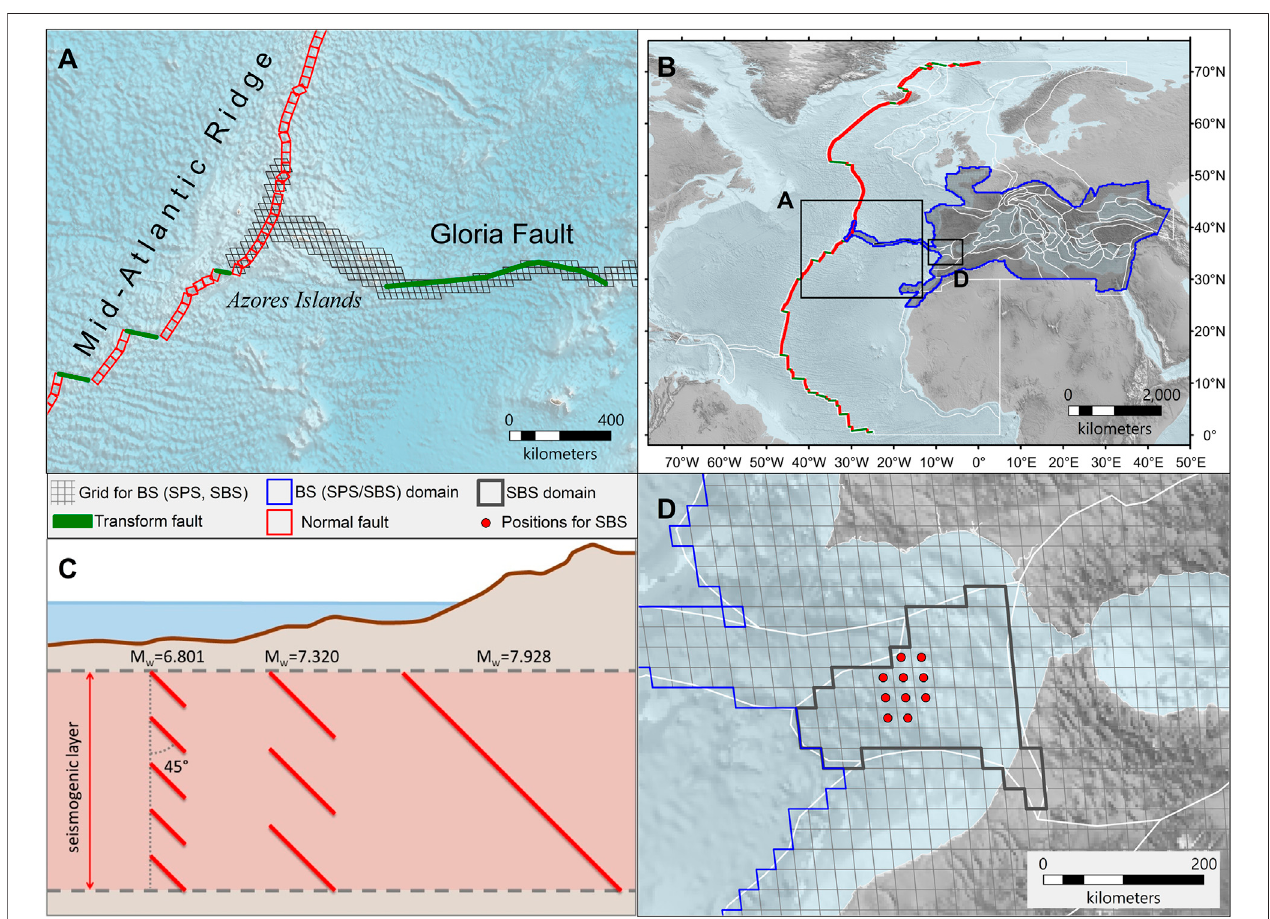
FIGURE 6 | (A) Close-up view of the Predominant Seismicity modeling type (PS) discretization in subfaults of the Mid-Atlantic Ridge and the Gloria Fault near the Azores Islands. Location of this map in panel (A) . There are in total 270 rectangular subfaults; 214 normal faults with a constant dip angle of 45 ° and size of 40 × 45 km; 57strike-slip(transform)faultswithaconstantdipangleof90 ° andsizeof55 × 20 km.See SupplementaryTableS6 forthecombinationsofsubfaultstomakeuplarge ruptures. The grid for the BS and SPS in this zone is also shown. (B) Regular grid (grey quadrangles, see the zoomed-in inset) composed of non-conformal equal- area cells of 25 × 25 km with the origin at 24 ° N – 3 ° E for the discretization of the background seismicity modeling type (BS). Note that cell sides depart from right angles withincreasingdistancefromtheorigininthisprojection.Theredoutlinemarksthecalculationdomain,outsidewhichonlythepredominantseismicitymodelingtype(PS) is modeled. The white outline of the tectonic regionalization ( Figure 4A ) is shown for reference. (C) Schematic of depth discretization for BS and SPS types due to the magnitude ofearthquakerupturesapplied to thecenter ofeach cell ofthegrid. Forthe SBStype, the magnitude range isextended toMw (cid:3) 9.026, and the depthlimit of thecrustalmodelisignored.Allmagnitudesarealwaysmodeledfortheshallowestdepthposition,irrespectiveofthecrustalthicknessbeingexceededornot.Wherethe crust isverythin, someofthedeeperpositionsarenotoccupiediftherupturecrossesthebaseofthecrust. (D) Cellsofthegrid(spatial discretization)intheCadizregion showing the positions (center of 10 grid cells) occupied by the SBS type of the Gibraltar Arc subduction interface. Location of this map in panel (A) . Topo-bathymetry is from the ETOPO1 Global Relief Model (NOAA, 2009; Amante and Eakins,